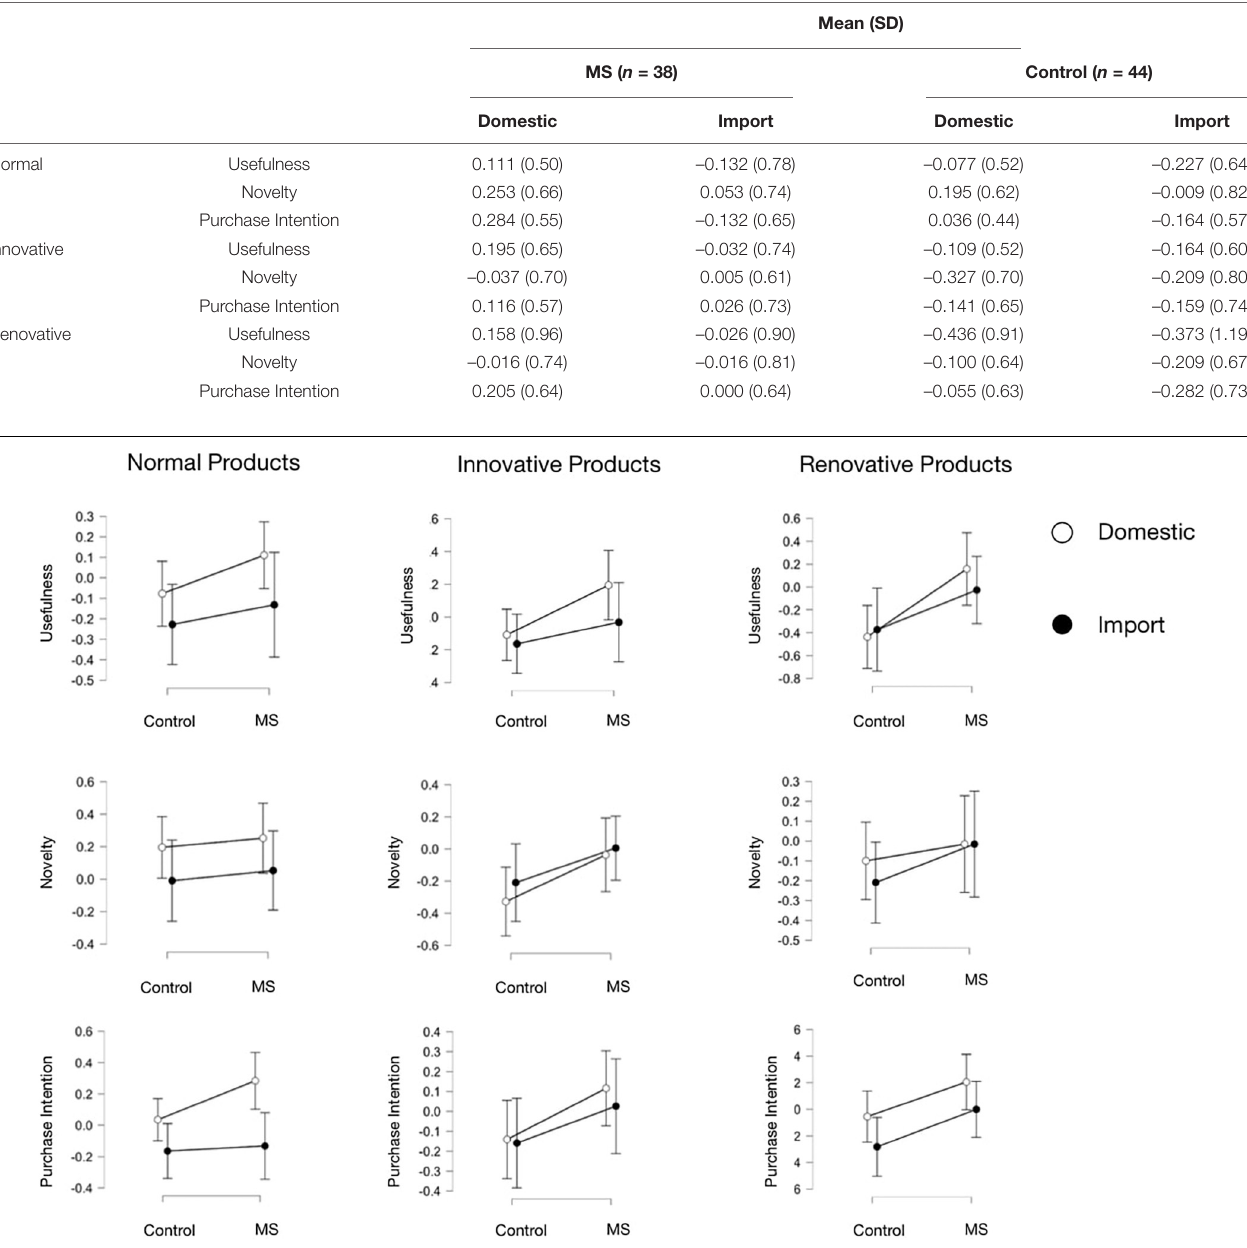
FIGURE 2 | The ANONA analysis results of Experiment